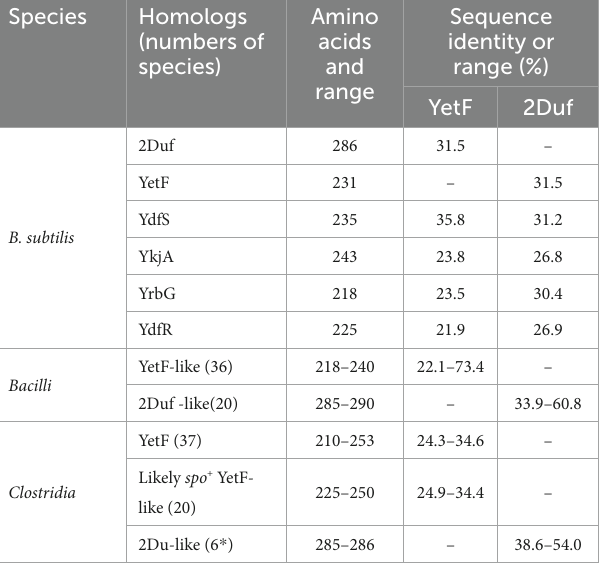
TABLE 2 Sequence conservation of YetF and 2Duf homologs in B. subtilis and other